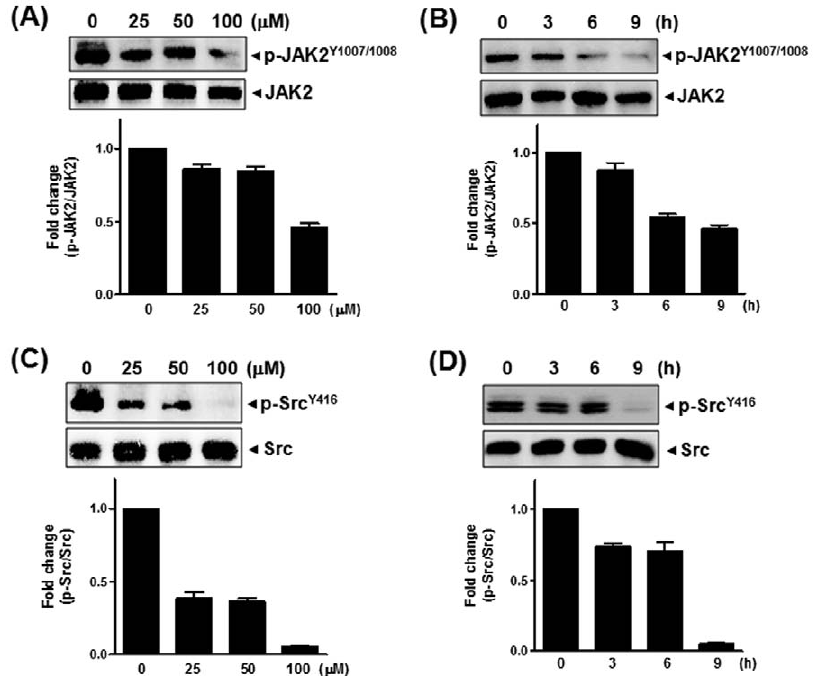
Figure 5. Effect of Icariside II on JAK2 and Src in U937 cells. (A and C) Cells were treated with Icariside II (0, 25, 50 or 100 m M) for 9 h. (B and D) Cells were treated with Icariside II (50 m M) for 0, 3, 6 or 9 h. Cell lysates were prepared and subjected to Western blotting for phospho-JAK2 and JAK2 (A and B), and phospho-Src and Src (C and D). Representative results of three independent experiments are shown for each experiment.